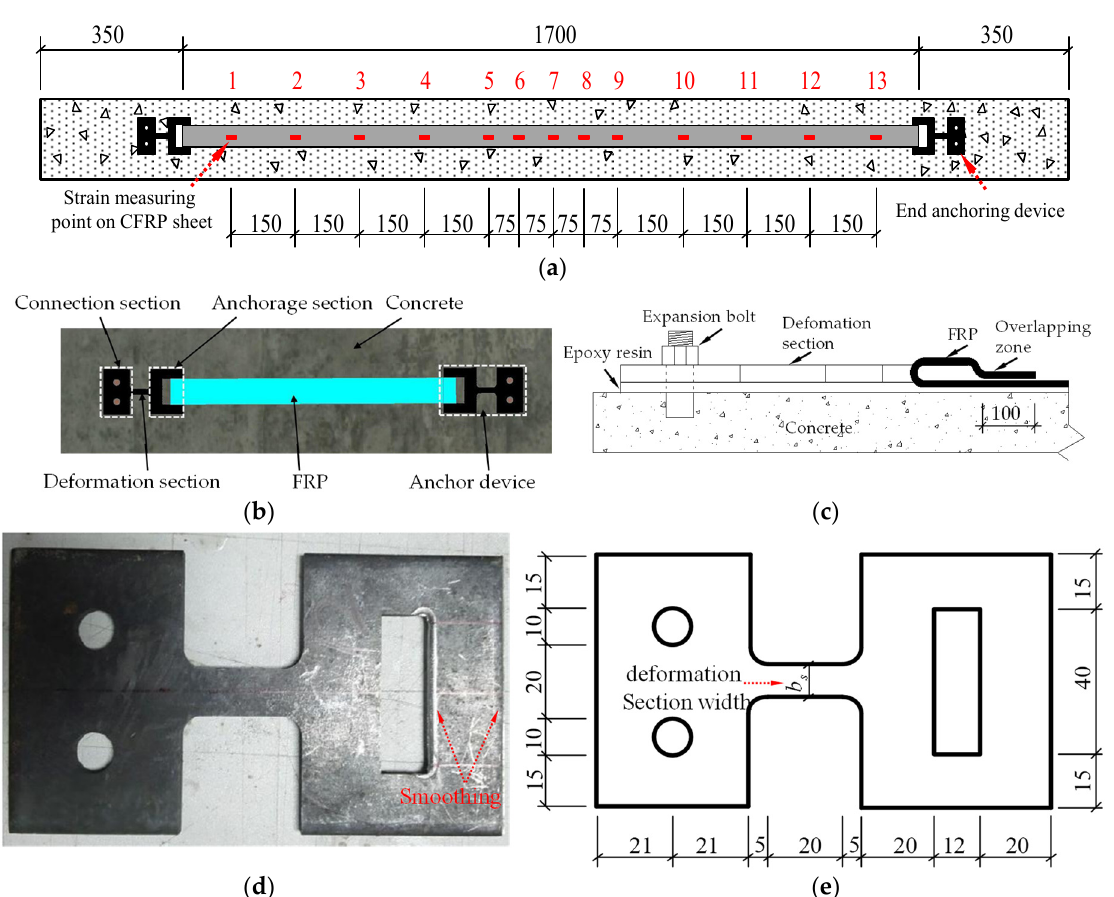
Figure 3. End anchoring of CFRP reinforced specimen (dimensions in mm). ( a ) Schematic diagram of end anchoring and measuring point arrangement. ( b ) End anchoring system. ( c ) Local map of end anchoring connection part. ( d ) Physical drawing of end anchors. ( e ) Dimensions of end anchors. Table 3. Specimen numbers and strengthening configurations.